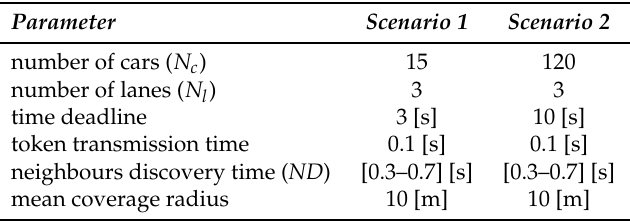
Table 1. Parameters adopted for Scenarios 1 and